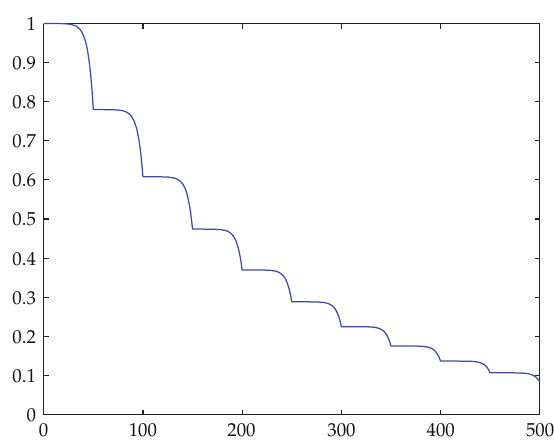
Figure 7: The Gauss collocation method with m (cid:4) 3 and p (cid:4) 50 for (cid:2) 7.2 (cid:3) .